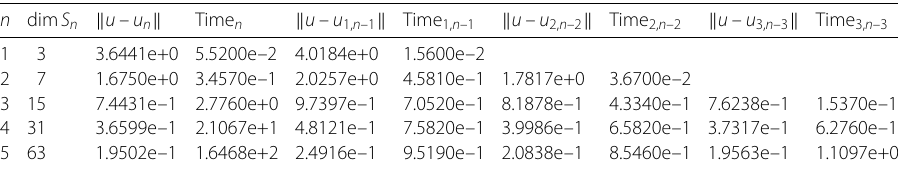
Table 4 Numerical results for p =